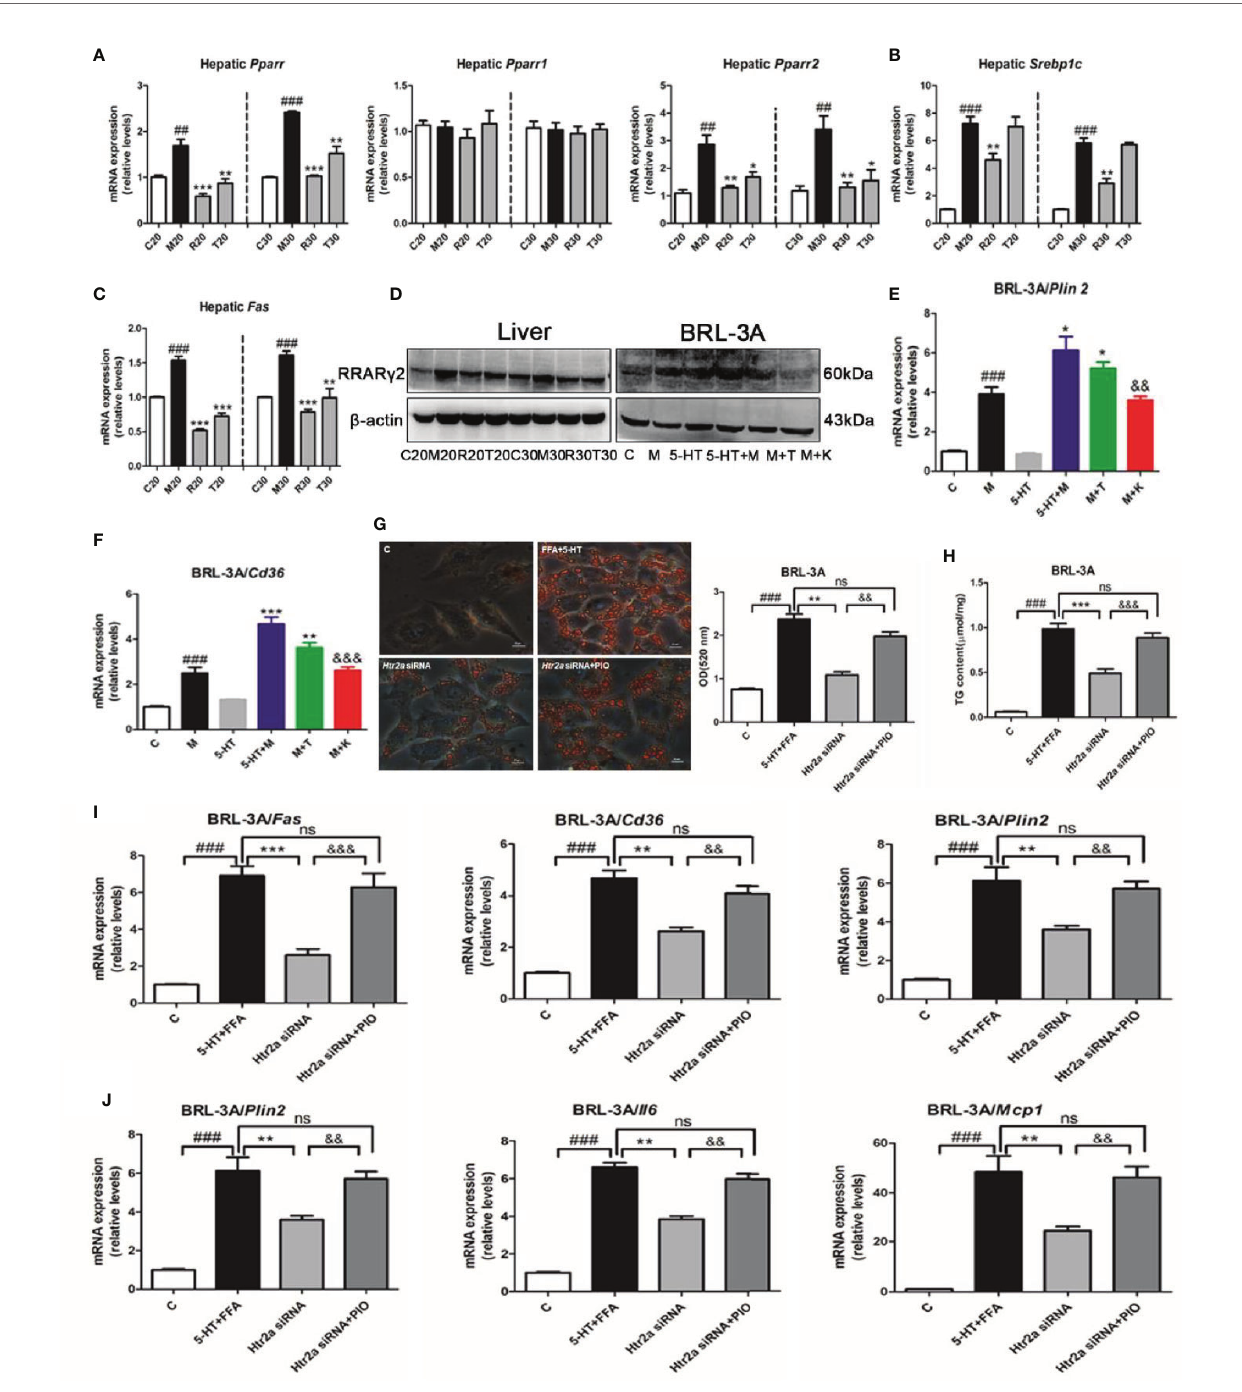
FIGURE 4 | The HTR2A/PPAR g 2 signaling pathway was involved in lipogenesis and the increased expression of in fl ammatory gene. (A) The messenger RNA (mRNA) expression of Ppar g , Ppar g 1 , and Ppar g 2 in the liver of SD rats. (B) The mRNA expression of Srebp1c in the liver of SD rats. (C) The mRNA expression of Fas in liver of SD rats (D) The protein expression of PPAR g 2 in BRL-3A and liver of SD rats. The mRNA expression of Plin2 (E) and Cd36 (F) in BRL-3A. (G) Oil red O staining and lipid content in BRL-3A cells (×400 magni fi cation). (H) The content of triglyceride (TG) in BRL-3A. (I) The mRNA expression of genes related to lipogenesis ( Fas , Cd36 , and Plin2 ) in BRL-3A. (J) The mRNA expression of genes related to the in fl ammatory response ( Tnf a , Il6 , and Mcp1 ) in BRL-3A cells. All data are presented as the mean ± SEM (n = 6). ## P < 0.01 and ### P < 0.001, compared with the corresponding control group; * P < 0.05, ** P < 0.01, and *** P < 0.001, compared with the corresponding model group; && P < 0.01 and &&& P < 0.001, compared with the 5-HT+M group. ns, represent no signi fi